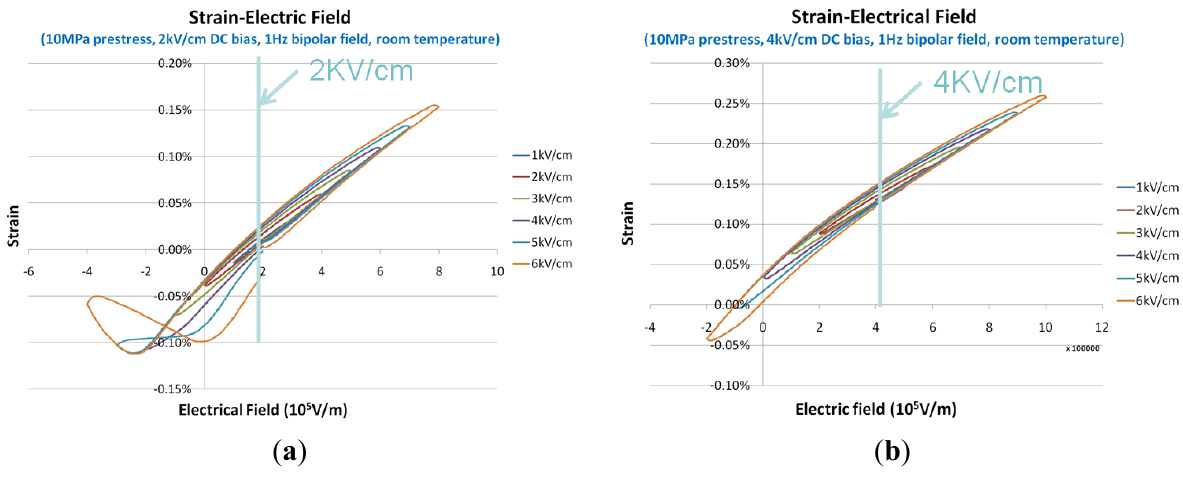
Figure 10. S-E loops of the same crystal sample as in Figure 9 measured under 10 MPa prestress and 2 kV/cm ( a ) and 4 kV/cm ( b ) external DC bias, respectively. Reprinted with permission from [86]. Copyright 2013